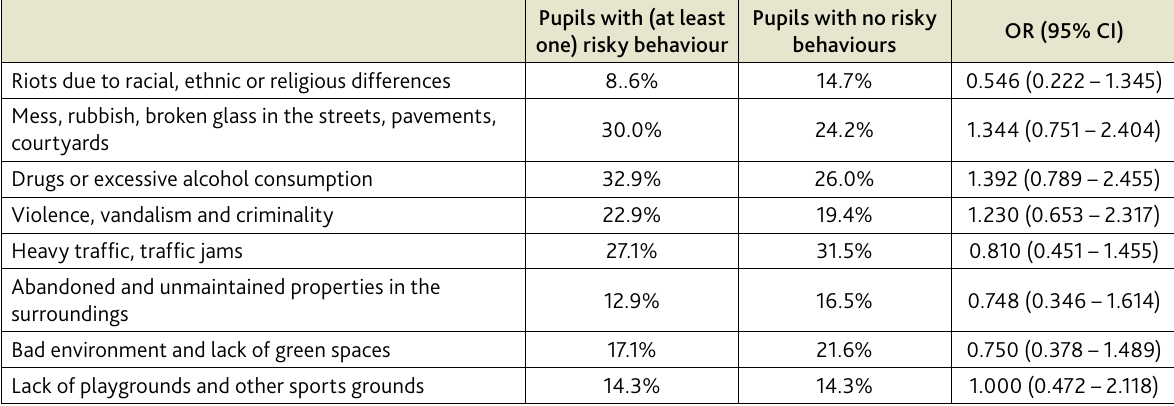
Table 6. Percentage of respondents who answered that they consider the following facts in the surroundings of their places of residence as highly or very problematic